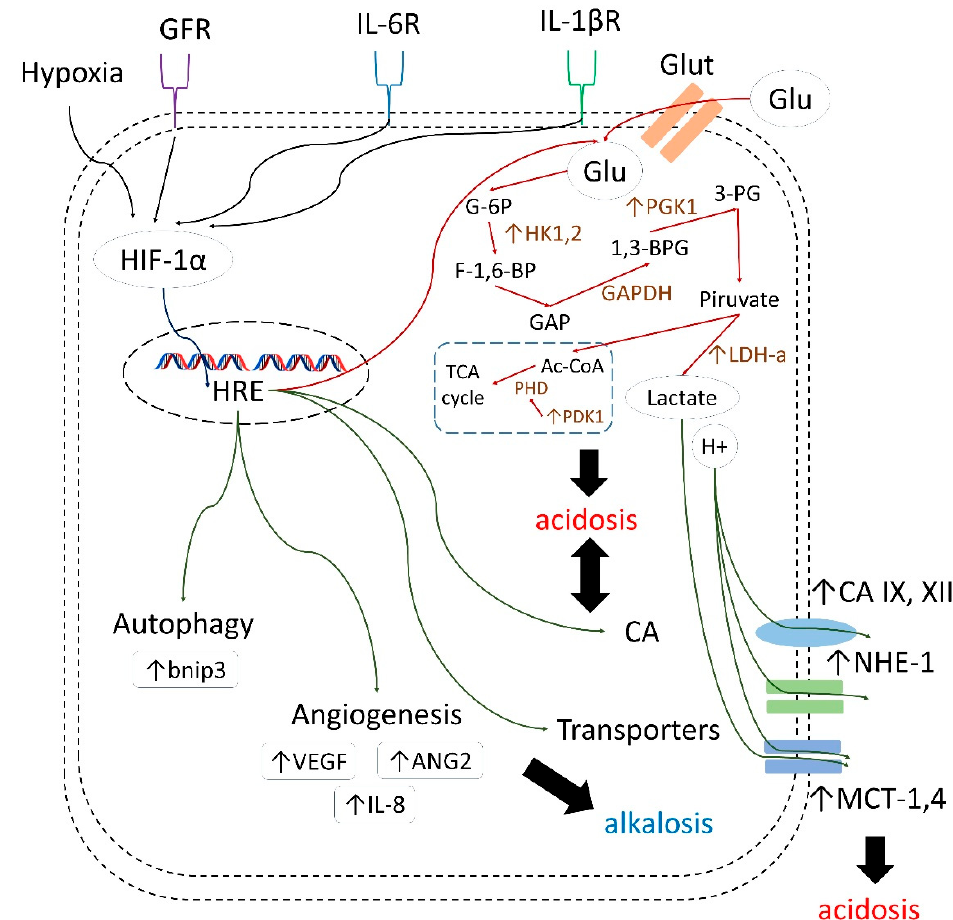
Figure 21. HIF-1 α /HRE-mediated adaptation of cancer cells to tumor acidosis [98–102].